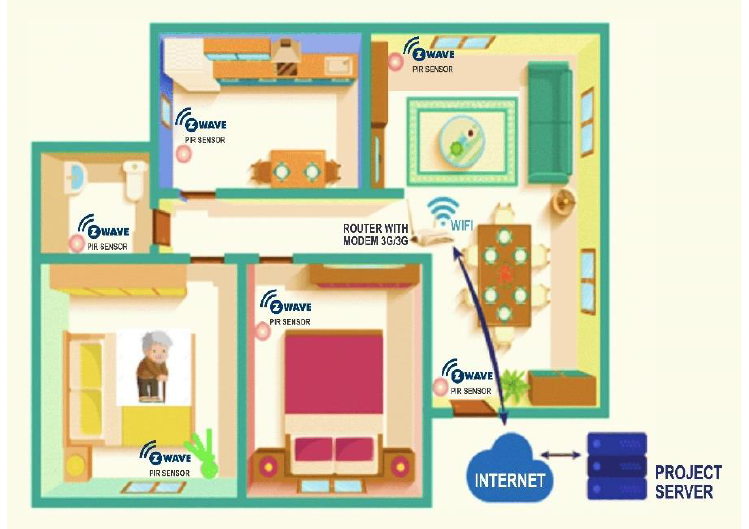
Figure 3. Detection system of basic and instrumental activities of daily